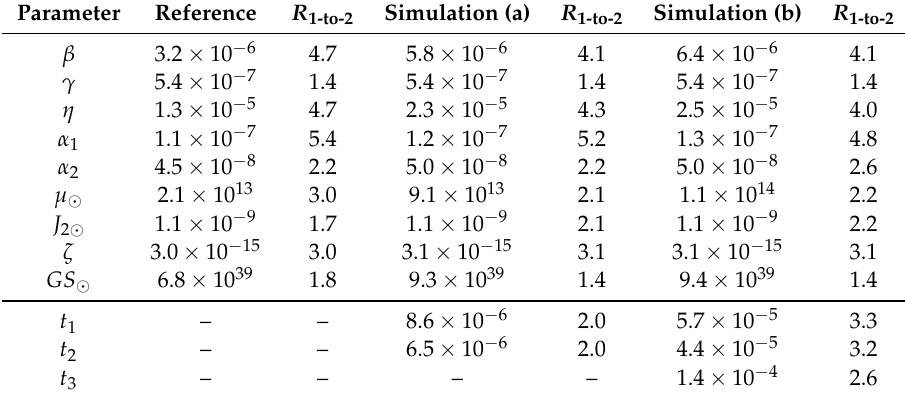
Table 5. Formal accuracies expected for the relativity parameters considering a twi-year long orbital experiment, in the case of: reference simulation, simulation (a) and simulation (b), respectively. For each case, we show the 1- σ accuracy (columns 2, 4, 6) and the improvement factor, R 1-to-2 , defined as the ratio of the one-year over the two-year accuracy (columns 3, 5, 7). Note that σ ( µ (cid:12) ) is expressed